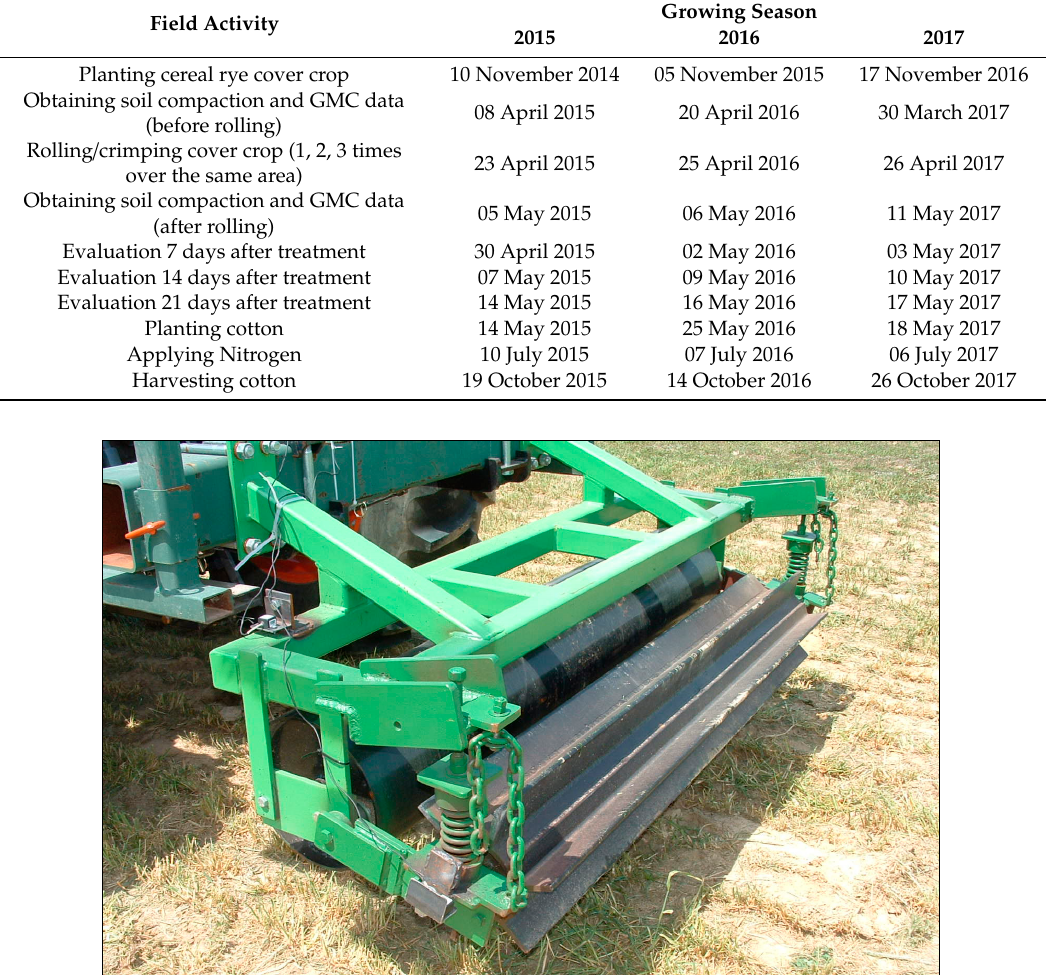
Figure 1. Two ‐ stage roller/crimper [28], US patent number: 7,987,917 B.1.